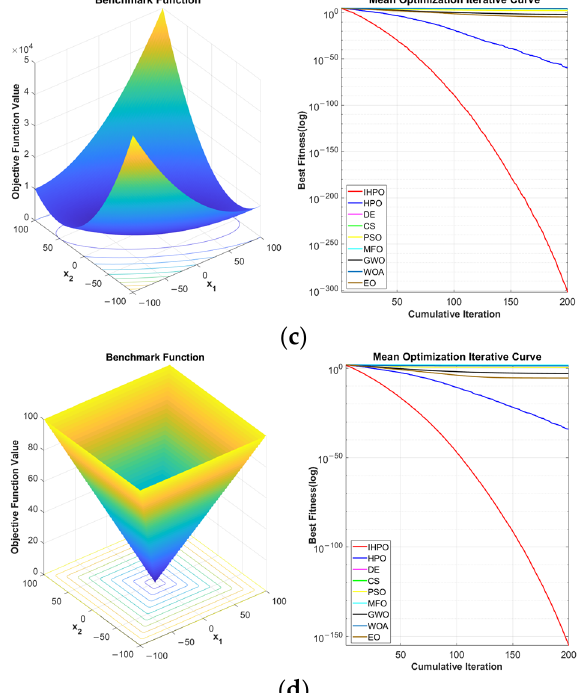
( ) f x ; ( b ) ( ) f x ; ( c ) ( ) f x ; 1 2 3